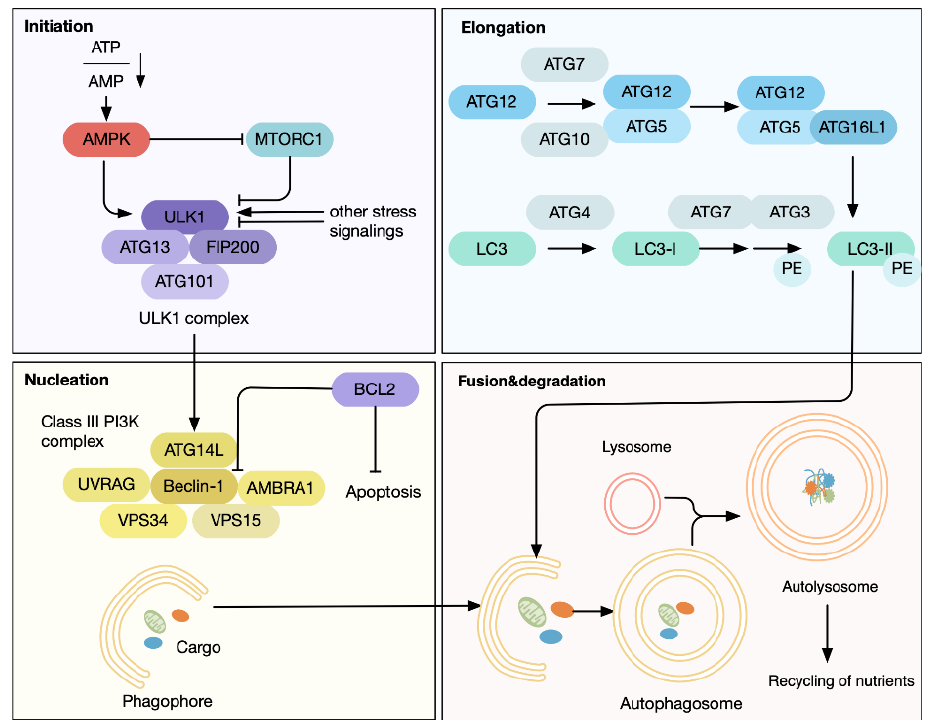
Figure 1. Functional mechanisms of autophagy. The most-studied form of autophagy is macroau- tophagy, a multistage and dynamic process. Autophagy is negatively regulated by the cell growth promoter rapamycin complex 1 (mTORC1), while the sensor of energy deprivation AMP-activated kinase (AMPK) activates autophagy. The canonical autophagy consists of four sequential stages: initiation, phagophore formation, phagophore elongation, and autophagosome–lysosome fusion [25]. During the initiation phase, the UNC-like autophagy-activating kinase 1 (ULK1) complex serves as a bridge between the upstream mTOR and AMPK and downstream autophagosome formation [26,27]. The complex is composed of ATG13, focal adhesion kinase-family-interacting protein of 200 kDa (FIP200), ATG101, and ULK1, in which ULK1 is the core protein with serine/threonine kinase activity [28]. After being stimulated by nutrient deficiency and stress-related pathways, phospho- rylated ULK1 subsequently leads to membrane nucleation, which requires activation of class III phosphatidylinositol-3 kinase complex I (PI3KC3-CI). Formed by beclin-1, vacuolar protein sorting 34 (VPS34), autophagy-related protein 14- like protein (ATG14L), p150, and nuclear receptor-binding factor 2 (NRBF2), this multiprotein complex can be activated through ULK-dependent phosphoryla- tion [29]. The nucleation of the isolation membrane, known as the phagophore, further expands with the support of PI3KC3-CI [30]. At the phagophore assembly site, the complex produces PI3P, favoring the recruitment of the effector proteins (such as WIPI/II), thus resulting in the phagophore elonga- tion [31]. This phase is further promoted by the ubiquitin-like conjugation system, involving the E1 ligase, ATG7, the E2 ligase, ATG3, and the E3 ligase complex, ATG12/ATG5/ATG16L [32]. Through ATG4-dependent proteolytic cleavage, followed by the action of the conjugation system, microtubule-